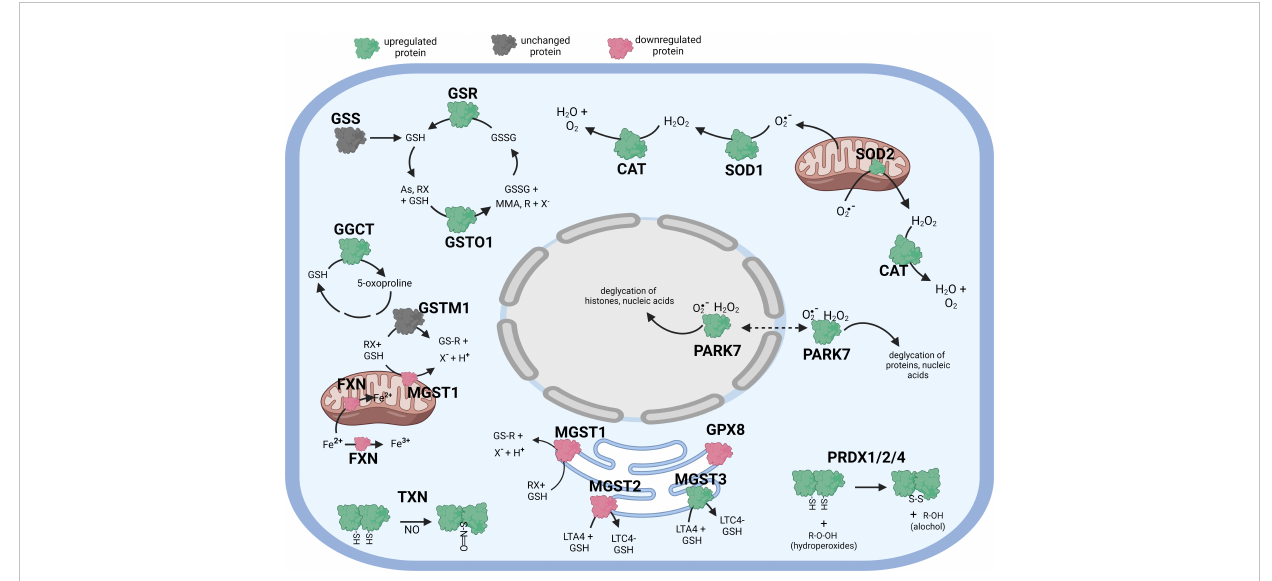
FIGURE 1 Diagramatic summary of the effect of tBHP exposure on antioxidant protein expression in hTERT-RPE cells. The antioxidant proteins focused on in this study are either upregulated (green), downreuglated (red) or unaffected (no change in expression) (grey) by oxidative stress. The arrows indicate the direction of a chemical reaction. Exposure of hTERT RPE cells to oxidant led to an increase in several proteins involved in glutathione homeostasis and transfer including GSR, GGCT, GSTO1 and MGST3. Conditions of oxidative stress also incerased the expression of PRDX1, PRDX2, PRADX4, SOD1, SOD2, CAT, TXN and PARK7. Figure created with